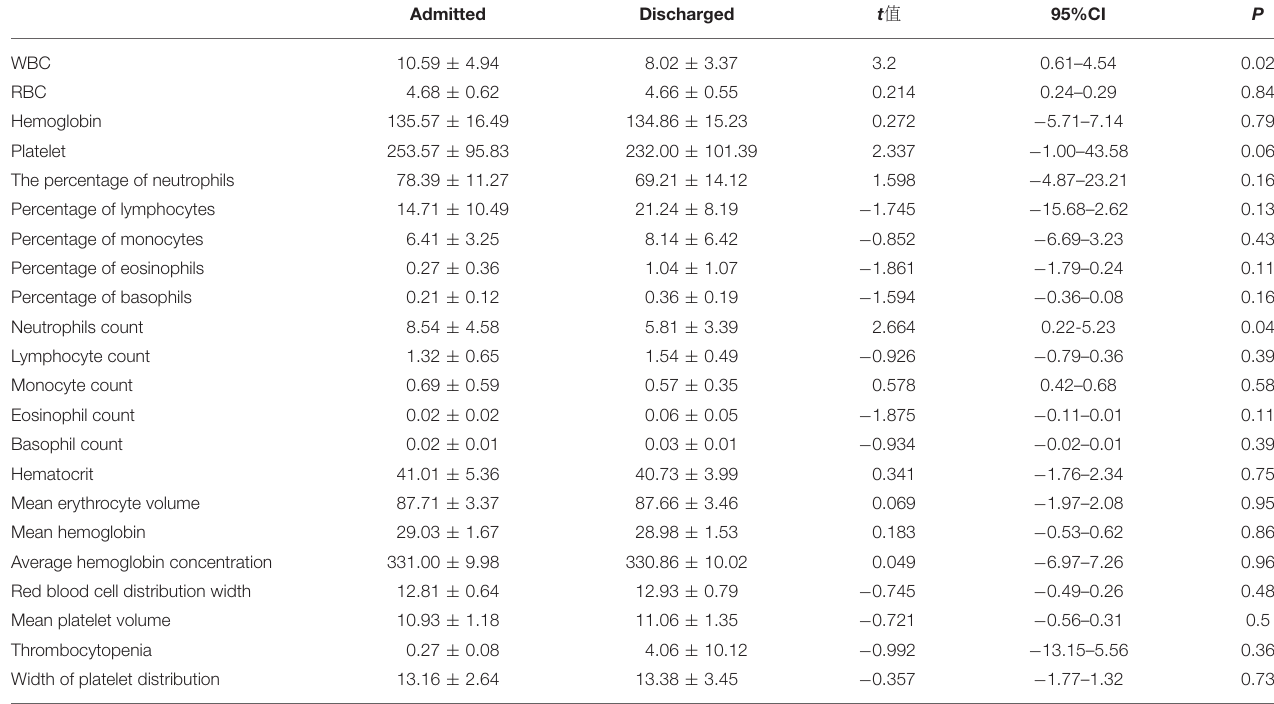
TABLE 3 | Comparative analysis of blood routine of 7 patients before and after